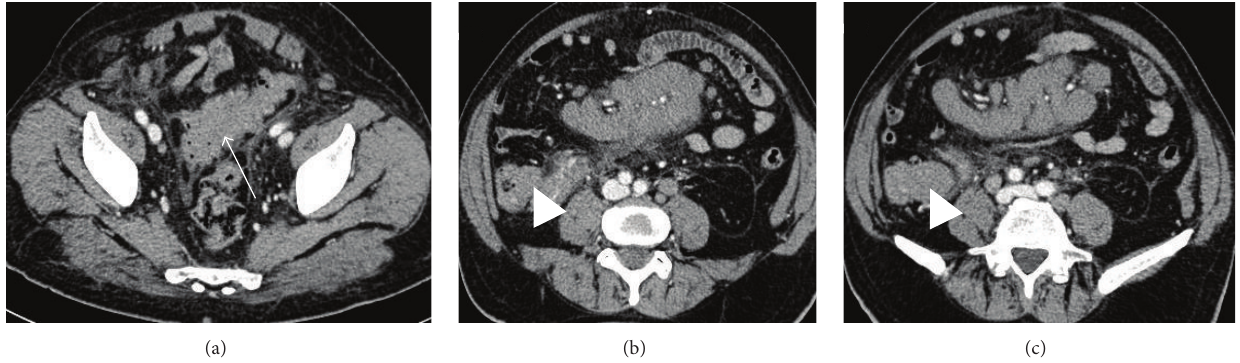
Figure 5: Abdominal CT scan of ileal and sigmoid lymphoma in a 78-year-old male. Axial CT scan in the portal venous phase shows a non-Hodgkin lymphoma seen as abnormal circumferential bowel thickening of the sigmoid colon ((a) arrow) and of the last ileal loop ((b) and (c) arrowheads). Enhanced lymphomatous small bowel loops (b) represent the halves of a sandwich, enveloping enhanced vessels (the sandwich filling). The patient underwent chemotherapy with marked reduction of the thickening at the follow-up CT